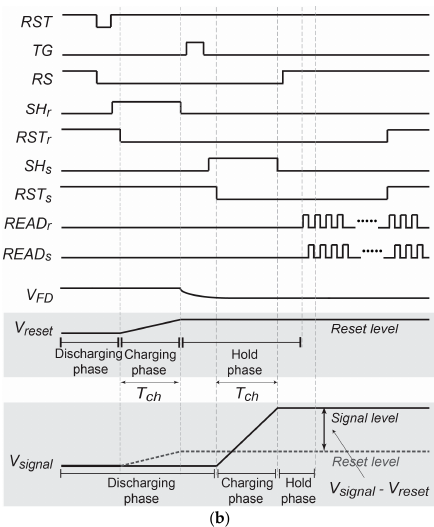
Figure 1. Basic schematic ( a ) and timing diagram ( b ) of the Gm-cell-based pixel with charge-domain sampling.